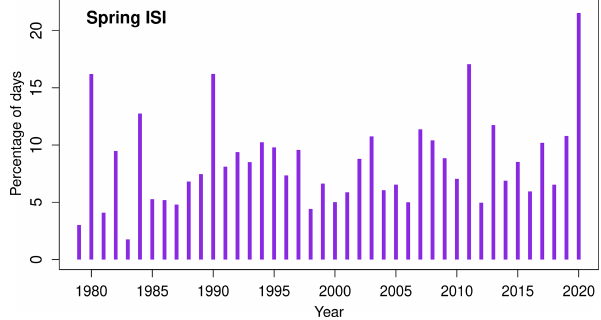
Figure 2. Monthly mean burned area (km 2 ) for the UK from 2003 to 2020 (from MODIS MCD64A1 data product).